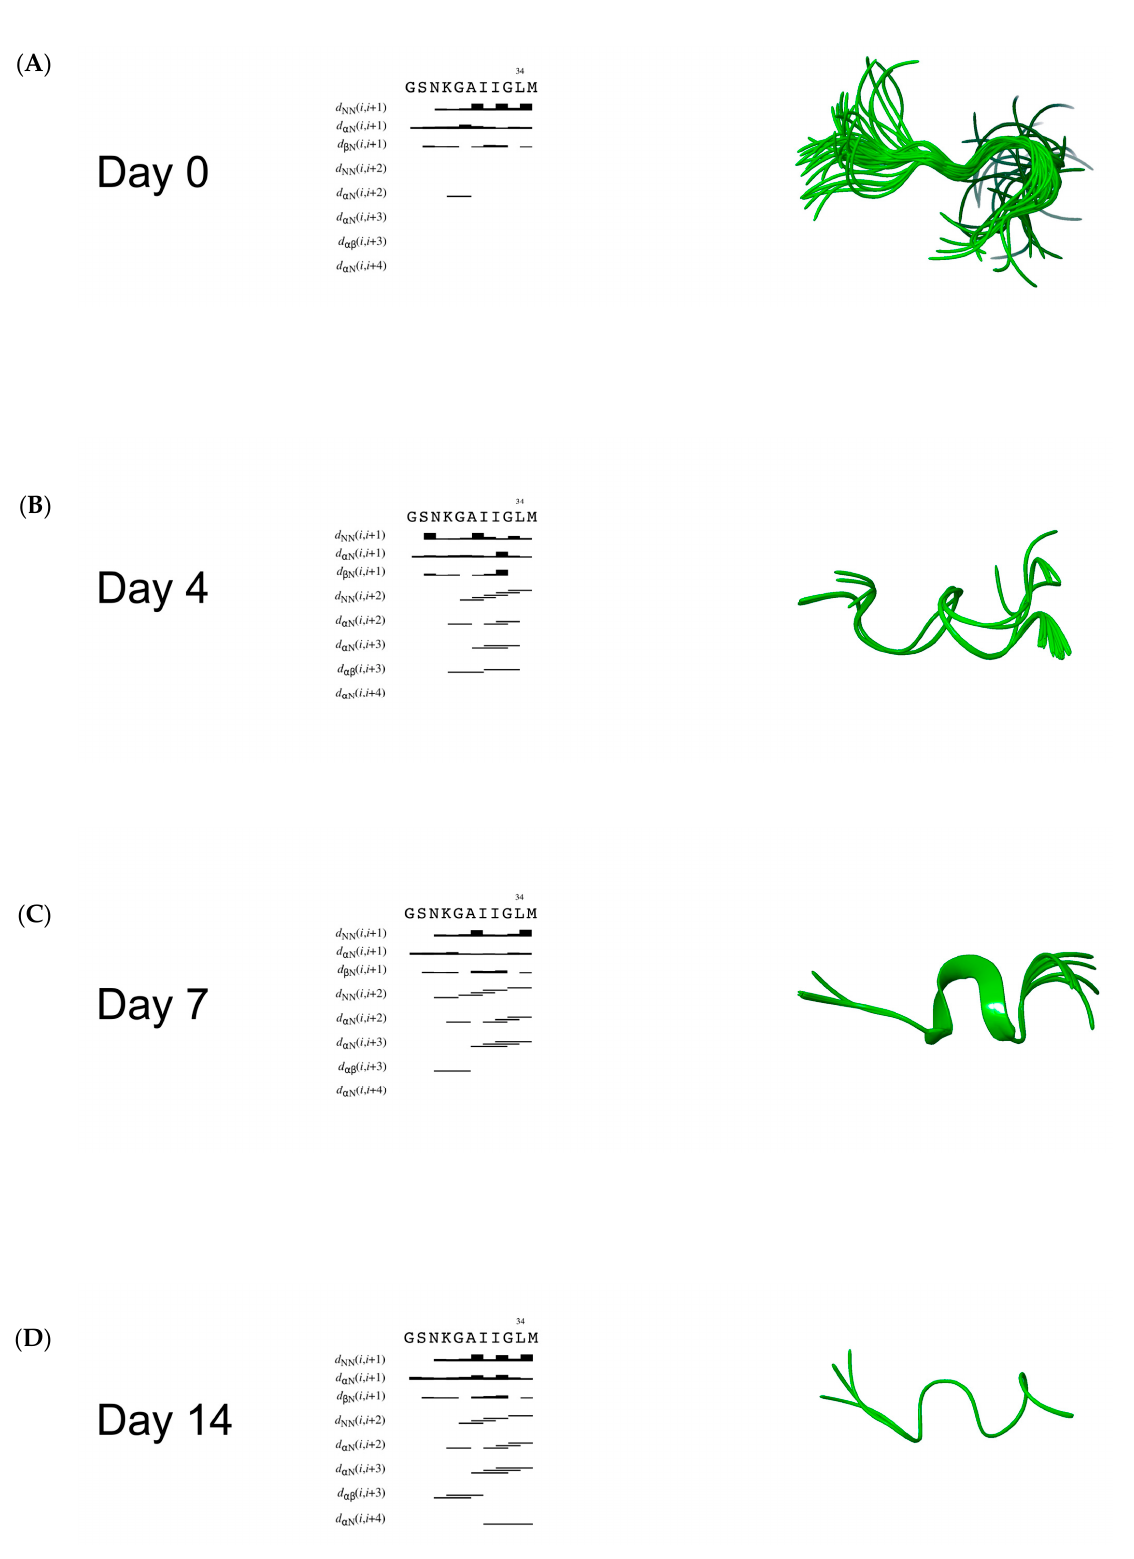
Figure 2. On the left, overview of the sequential and medium-range nuclear Overhauser enhance- ments (NOEs) used to calculate the A β (25 − 35) structure ensembles obtained at day 0 ( A ), day 4 ( B ), day 7 ( C ) and day 14 ( D ). On the right, ribbon visualization of the representative structures of the corresponding calculated